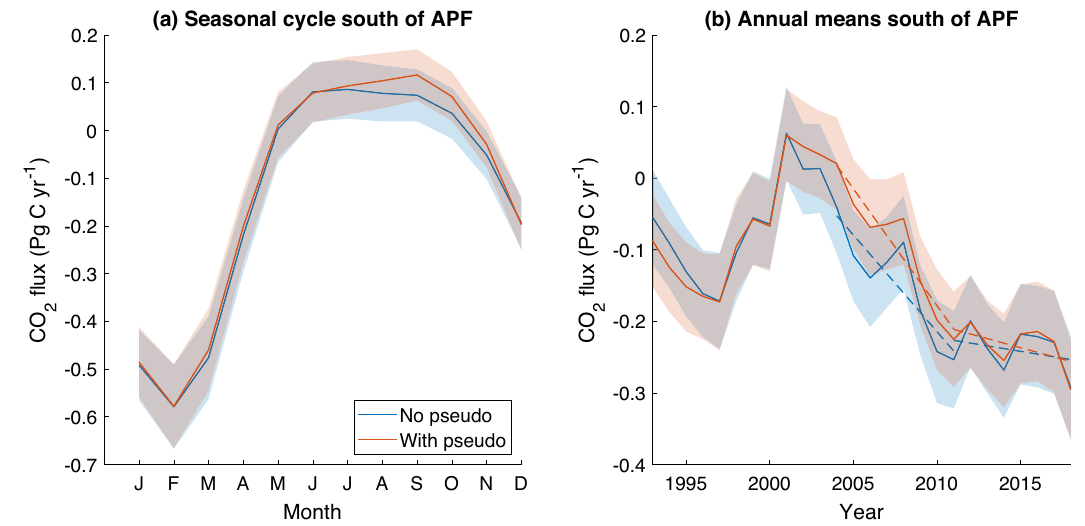
Fig. 3 Air-sea CO 2 fl uxes south of the Antarctic Polar Front. a 1993-2018 mean seasonal cycle and b annual mean air-sea CO 2 fl uxes (negative into the ocean) south of the Antarctic Polar Front based on sea surface fCO 2 from the SOM-FFN with and without pseudo observations in the training data. Values are Petagrams of carbon per year (Pg C yr − 1 ). Each solid line represents an ensemble mean, and the shaded areas are the 1- σ uncertainties (see Methods section). The dashed lines on b are linear fi ts for the 2004 – 2011 and 2011 – 2018 periods.